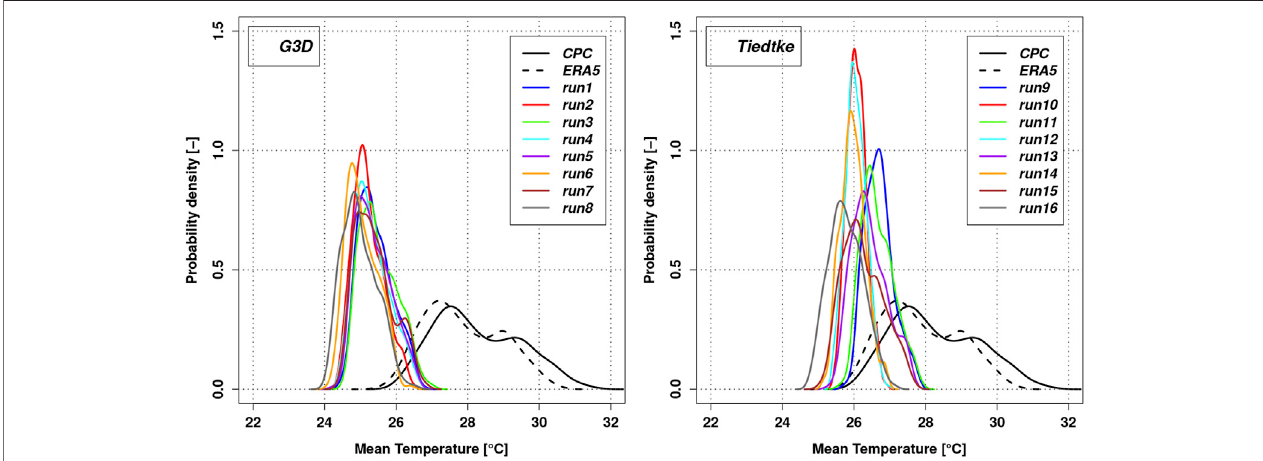
FIGURE 5 | Probability Density Function (PDF) of the simulated (JJA) daily mean temperature in the 16 WRF runs using G3D (left) and Tiedtke convection scheme (right) for domain 2 (2006 – 2010). CPC and ERA5-Land are given as reference precipitation.